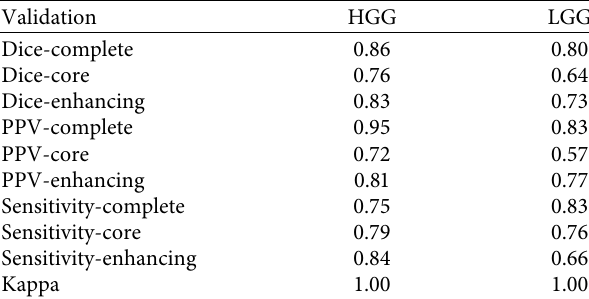
Figure 5: The number of dictionary atoms and the accuracy of segmentation. Table 3: The average correct rate of 200 patients with segmentation in the training data